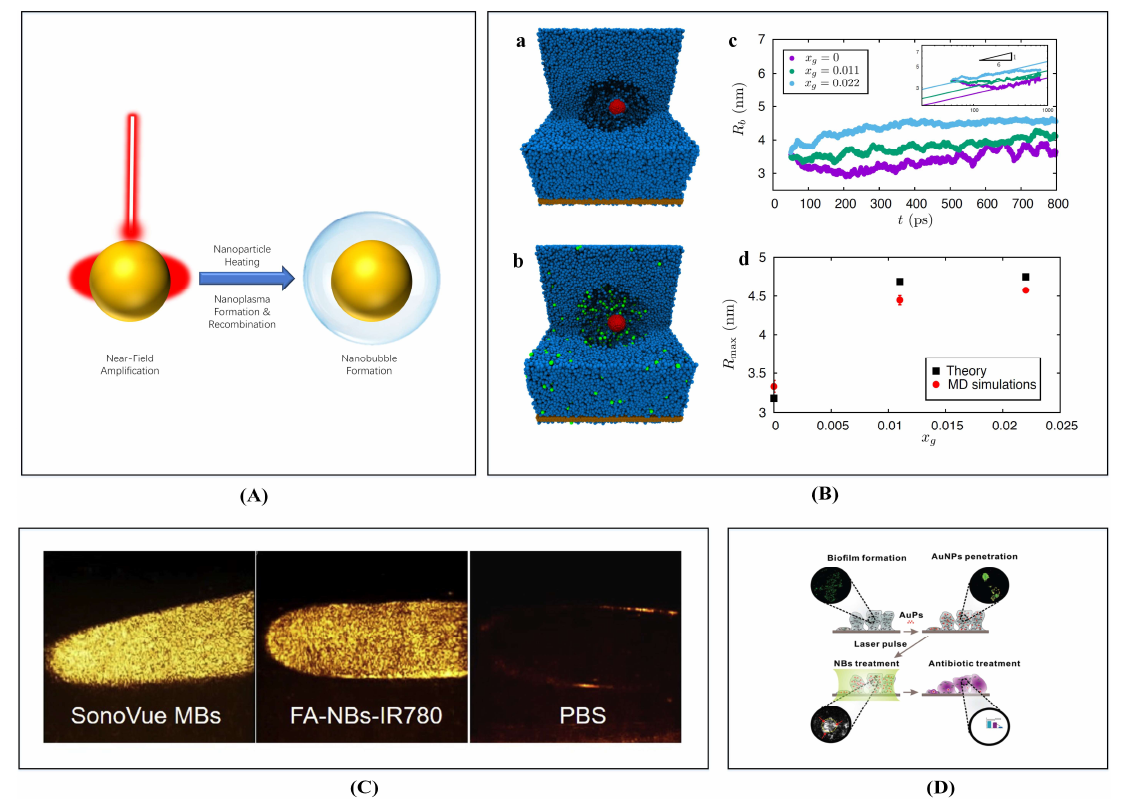
Figure 7. Simulation and experiments of nanobubble in LFL. ( A ) Generation of water vapor NBs around the irradiated NPs under pulsed laser irradiation [36]. Reprinted with permission from